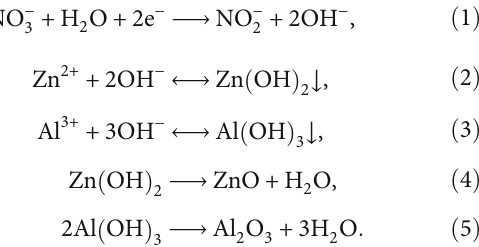
Figure 1: Cyclic voltammogram of the 3mM Zn(NO distance 2cm and the scan rate 30 mV/s at (a) 80 ° C and (b) 20 °